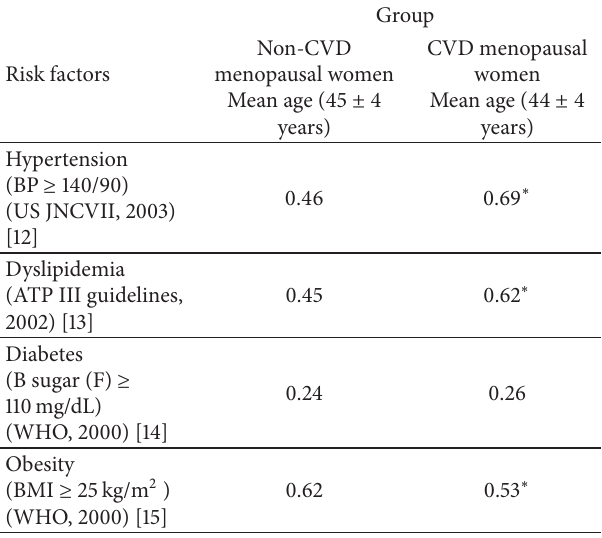
Table 1: Frequency of risk factors in menopausal women (with and without CVD).